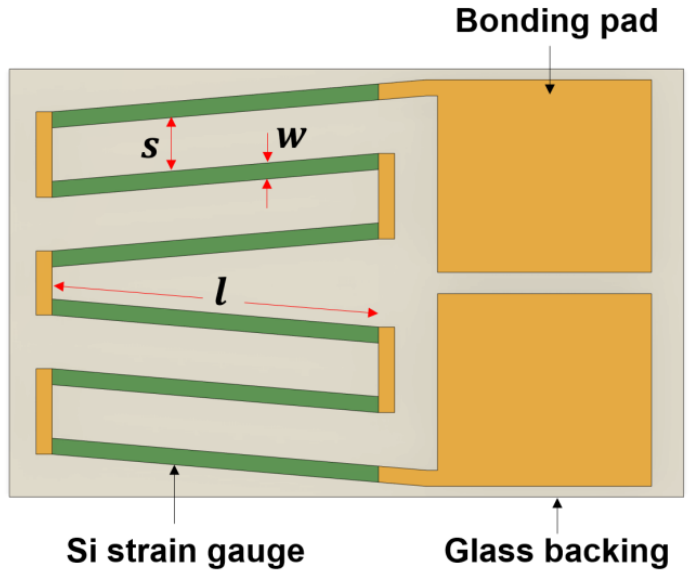
Figure 5. Single strain gauge pattern designed for radial strain sensing and its design parameters. To determine the gauge locations on the top surface of the circular diaphragm, the strain distribution in the pressure-loaded steel diaphragm was obtained from finite element analysis (FEA) by ANSYS, as shown in Figure 6. The material of the diaphragm was 630 stainless steel (SUS 630), which is currently the most widely used material for pressure sensors. The pressure range was determined by the structural parameters of the diaphragm, such as thickness ( h ), radius ( R ), and fillet radius ( r ). The parameters used in the simulation and calculation are as follows: Young’s modulus, E = 1.93 × 1011 Pa; Poisson’s ratio, ν = 0.31; available radius, R = 3.4 mm; thickness, h = 0.4 mm; fillet radius, r = 0.5 mm; and applied pressure, p = 50 bar.